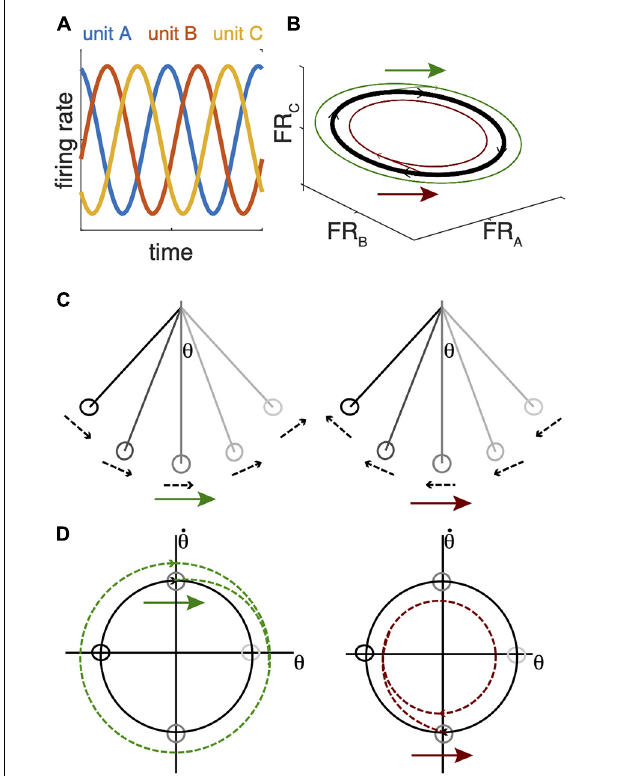
FIGURE 3 | Analogy between a simple pendulum and cortical firing rate state-space dynamics. (A) Idealized periodic changes in firing rates for 3 single units. (B) The firing patterns of the units in (A) trace an elliptical orbit in the firing rate state space. In an actual recording, more units would be recorded, and many more would be unobserved. Population dynamics are often analyzed with a dimensionality-reduction technique to project the high dimensional firing rate state space (one dimension per neuron) into a subspace that accounts for most of the variance in the recorded signal (e.g., Churchland et al., 2012). (C) A simple pendulum also traces a rotating trajectory in the state space defined by its angular position ( θ ) and velocity (D) . The same perturbation arrows in (B–D) can expand (green arrows) or shrink (red arrows) the state space rotation depending on their timing with respect to these state space rotations. In the case of the pendulum, this reduces its maximum angular position and velocity; in the case of neural dynamics, this would reduce the range of neuronal firing rates and theoretically reduce movement amplitude and